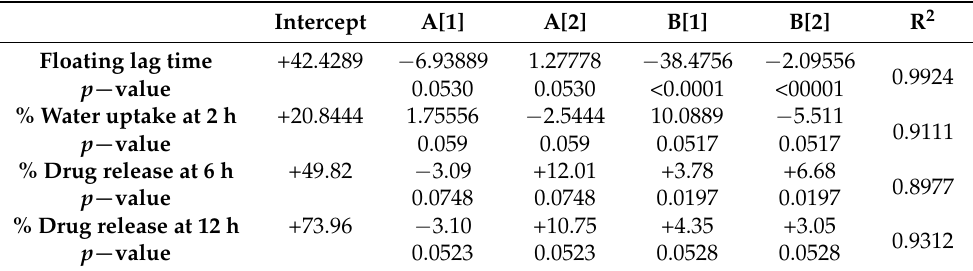
Table 7. Multiple regression output for dependent variables, showing the intercept, relationship between the factor and variables, and p -value obtained from the